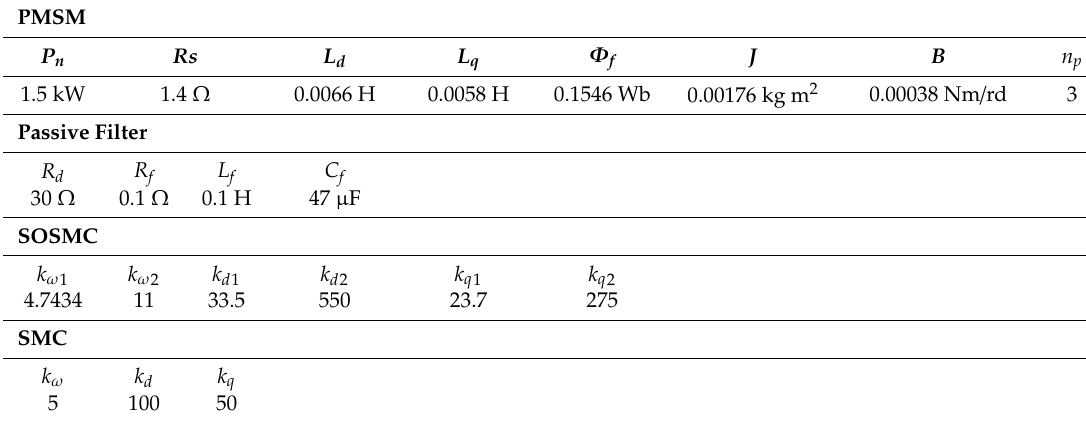
Table 3. Drive system